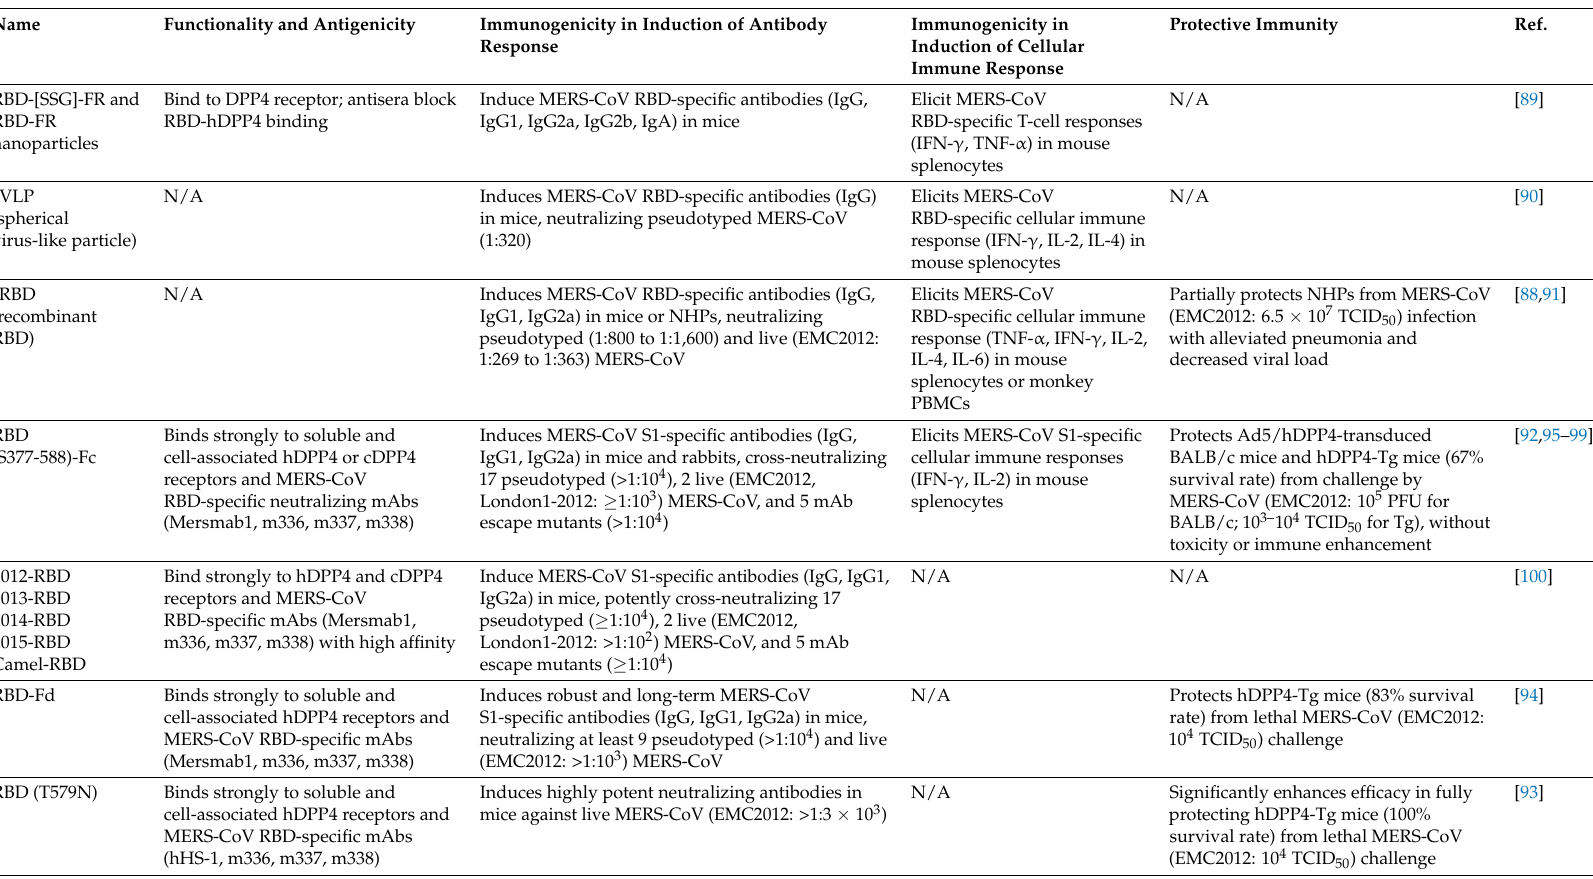
Vaccines based on MERS-CoV RBD. Live MERS-CoV strains used for neutralization and challenge experiments, as well as vaccine-induced neutralizing-antibody titers, are described in